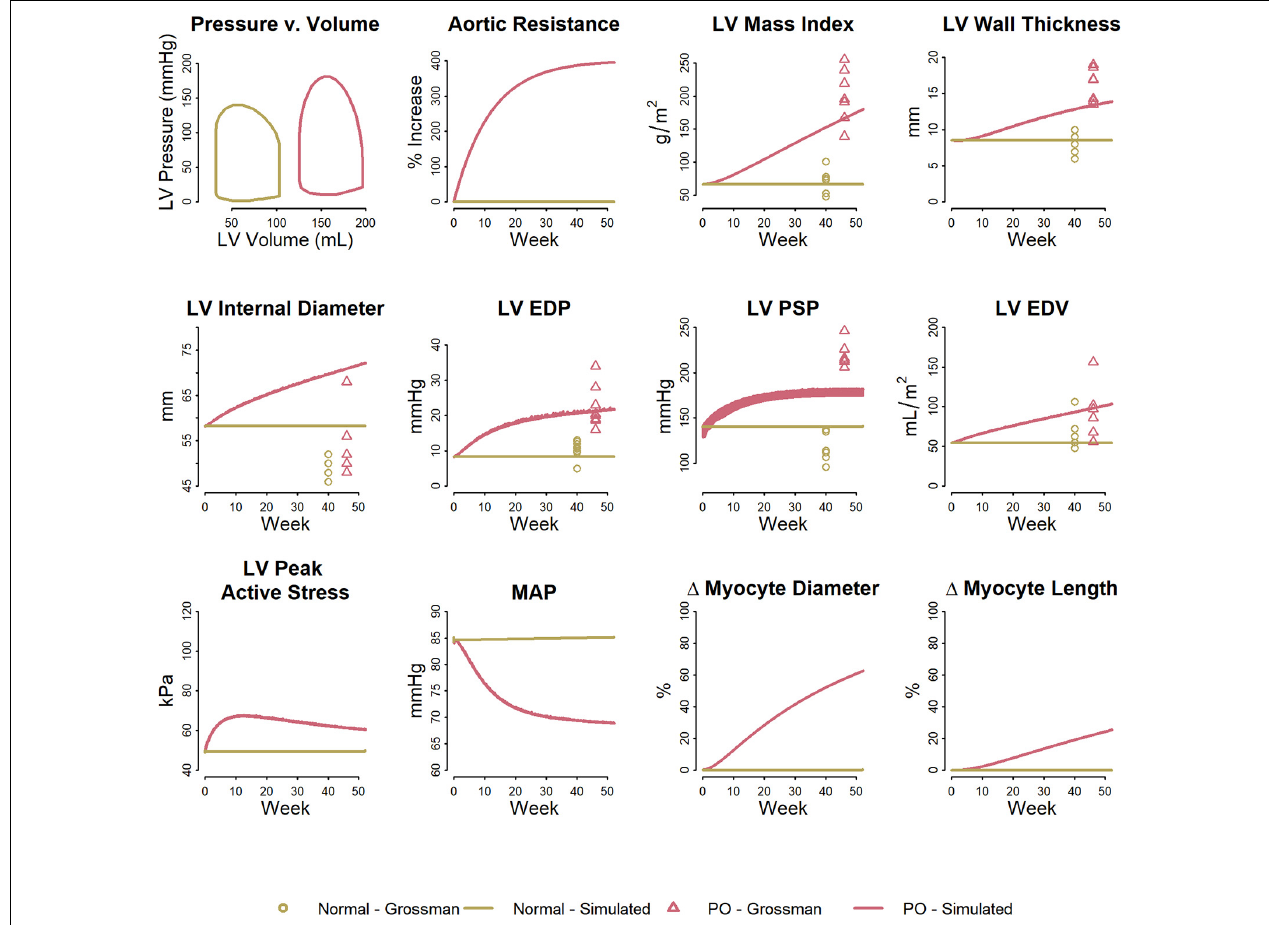
FIGURE 3 | Model reproduces observed patterns of hypertrophy in pressure overload due to aortic stenosis. Data from Grossman et al.